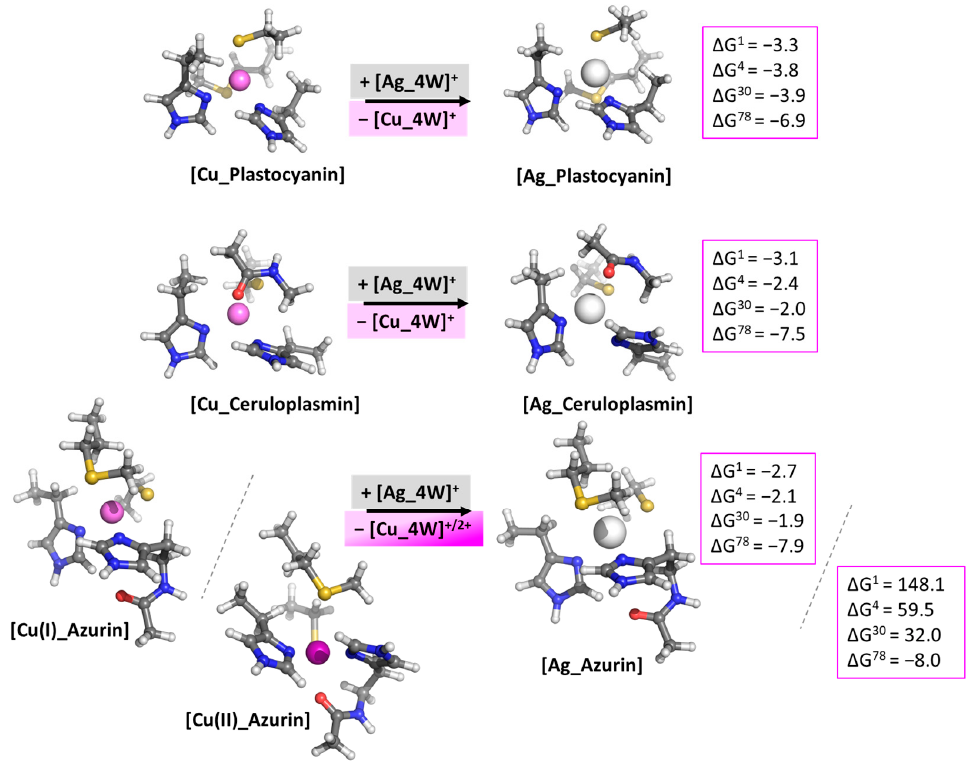
Figure 6. Gibbs energies of Ag + → Cu + substitution given in kcal.mol − 1 in four different environments (denoted as ∆ G 1/4/30/78 ) for M062X/6-311++G(d,p)/SDD-optimized M_Plastocyanin (Class 1), M_Ceruloplasmin (Class 2), and M_Azurin (Class 3) structures. The applied color scheme has been previously presented in Figure 3. The results for the Ag + → Cu 2+ substitution in the metal-binding center of Azurin have also been obtained and presented, along with the fully optimized Cu 2+ -bound structure modeled in accordance with the available X-ray structure (PDB Entry: